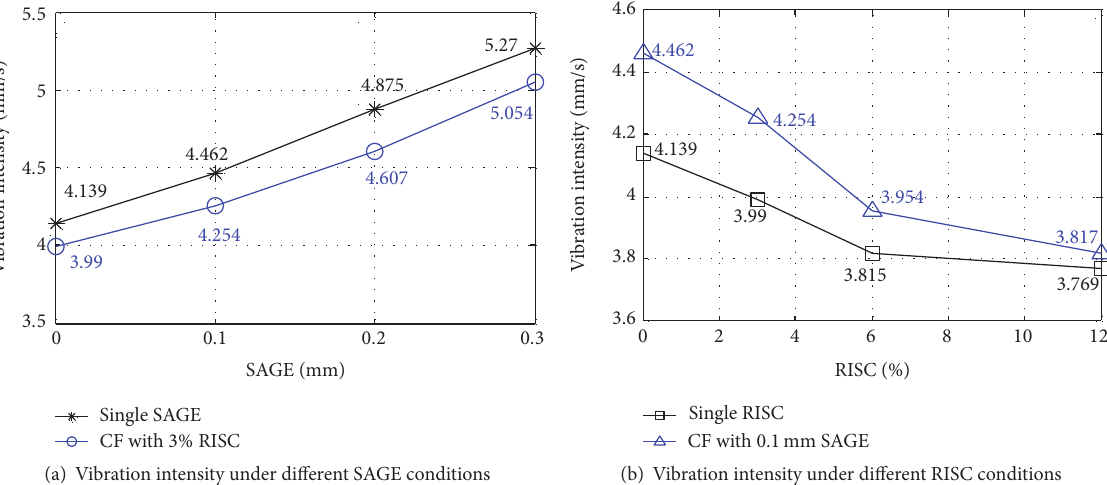
Figure 5: Time domain curves of MPPUA under different conditions.